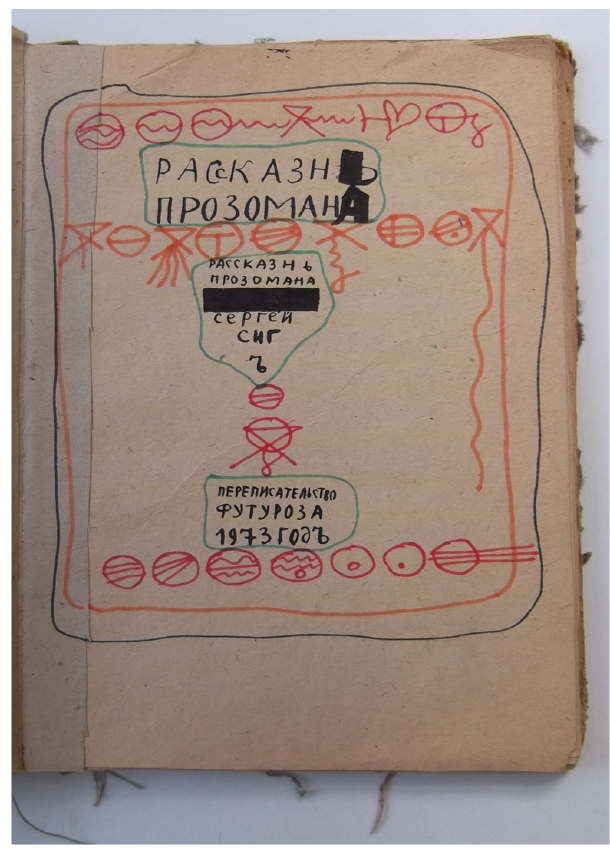
Figure 22. Title page of ‘Raskazn”.